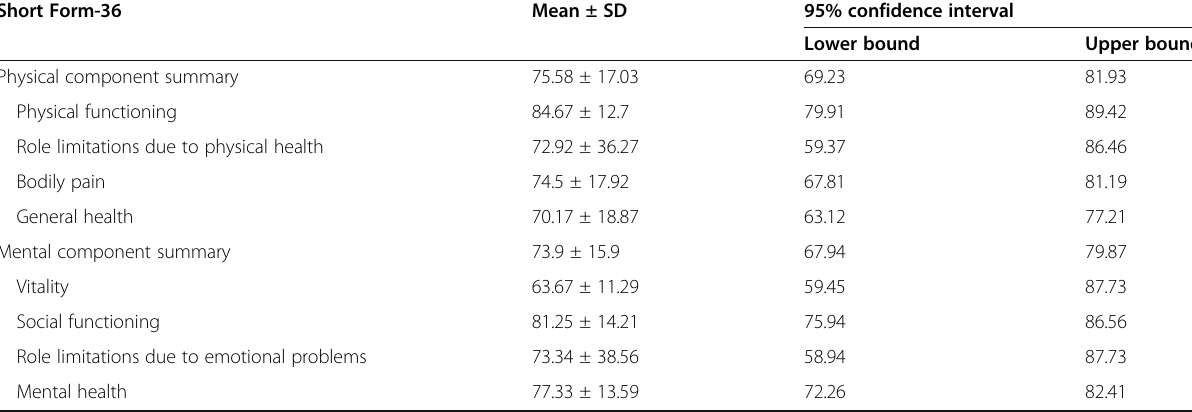
Table 3 Short Form-36 component summary and domain scores Short